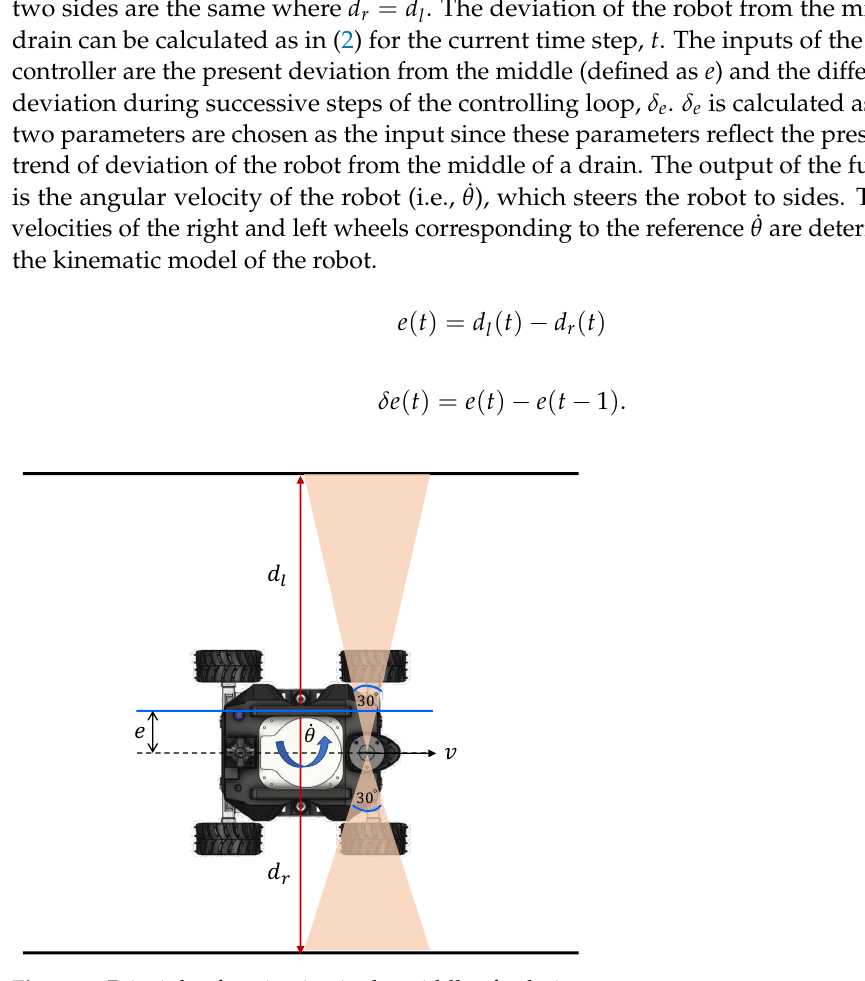
Figure 9. Principle of navigating in the middle of a